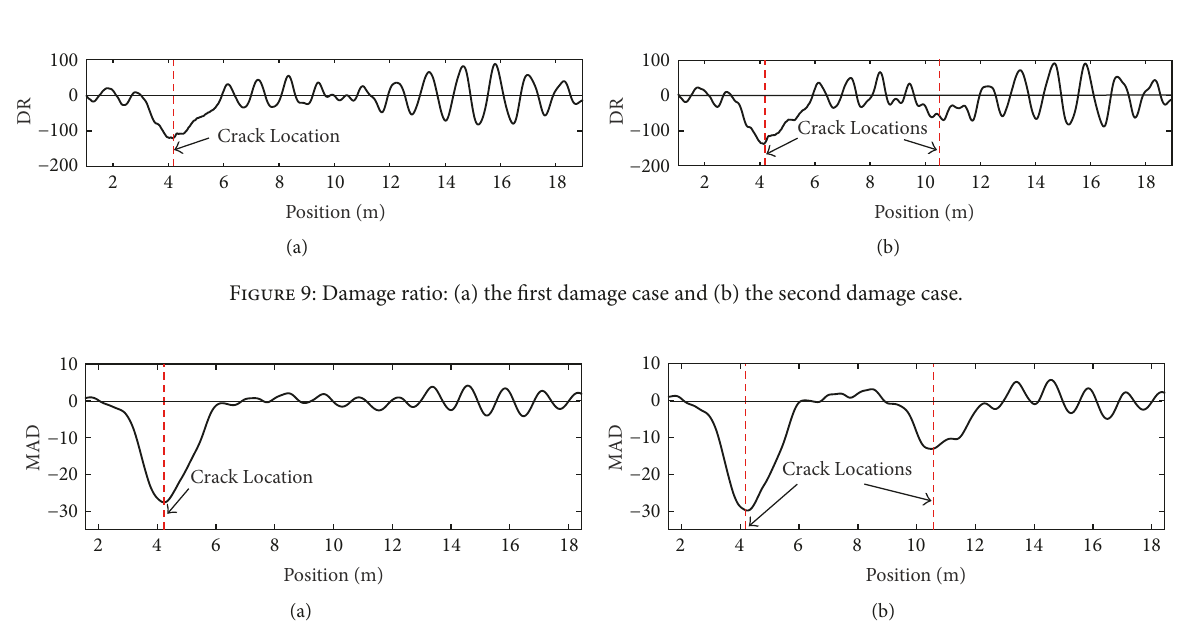
Figure 8: Comparison of RIC av for healthy and damaged cases: (a) the first damage case and (b) the second damage case.